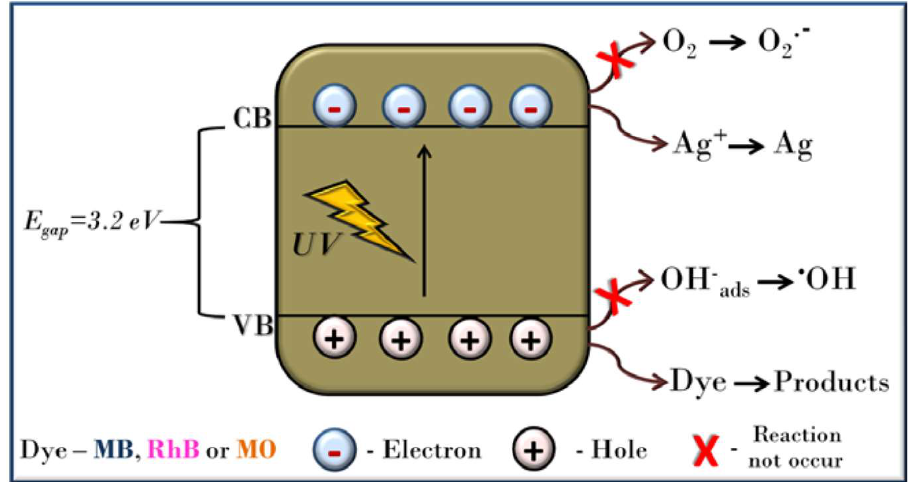
Figure 5. Plausible mechanism for the photocatalytic reaction catalyzed by the SrTiO 3 photocata- lysts [72]. Reprinted/adapted with permission from John Wiley and Sons, 2009.